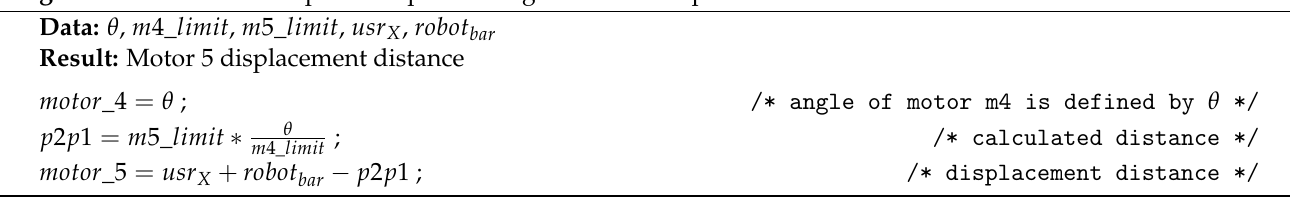
Algorithm A2: Relationship of the aperture angle with the displacement of the motors m1, m2 and m3 Data: Angle φ , Motors current positions [ cp m 1 , cp m 2 , cp m 3 ] Data: threshold = 90 ◦ , Motors initial positions [ ip m 1 , ip m 2 , ip m 3